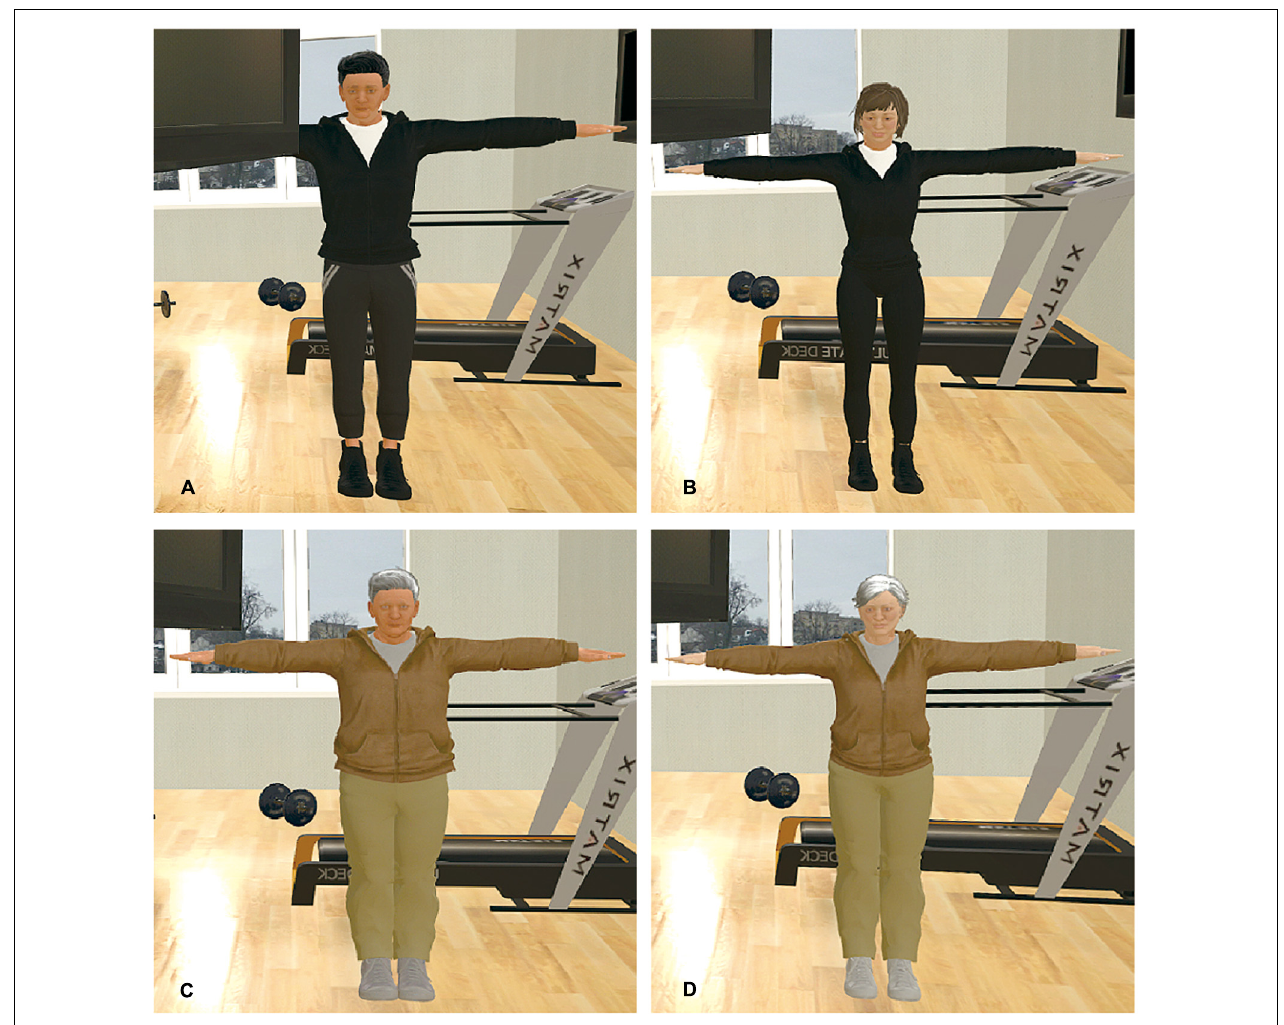
FIGURE 2 | Avatars. (A) Young male. (B) Young female. (C) Older male. (D) Older female.